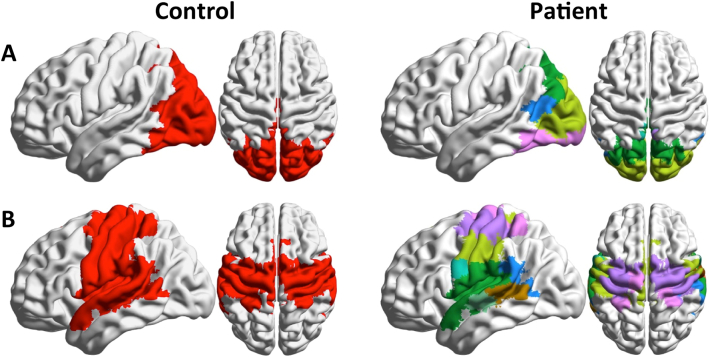
Module 1 and 2 (A and B, corresponding to visual and sensorimotor cortices, respectively) of the control group (left), and overlapping modules in the patient group (right). These modules are substantially fragmented and reorganized in the SCZ group compared to healthy controls.